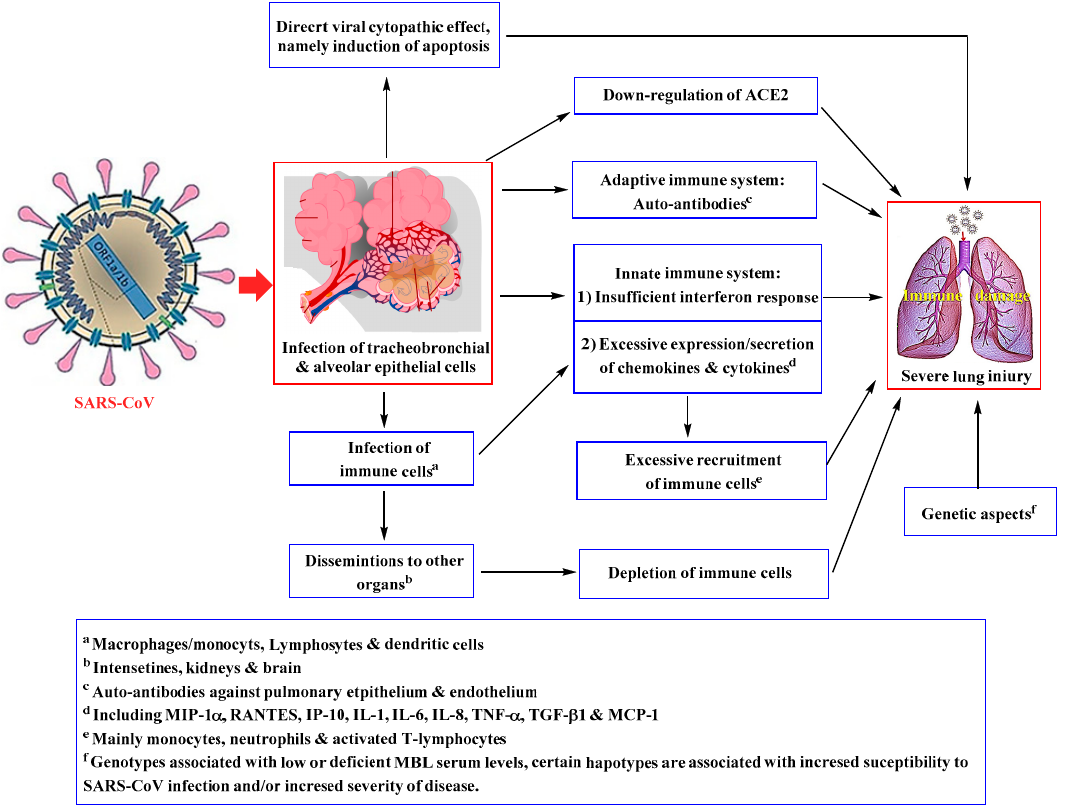
pathogenesis. TGF- β 1: transforming growth factor- β 1; MIP-1 α : macrophage-inflammatory protein-1 α ; RANTES: regulated on activation / normal T cell expressed and secreted; TNF- α : tumor necrosis factor- α